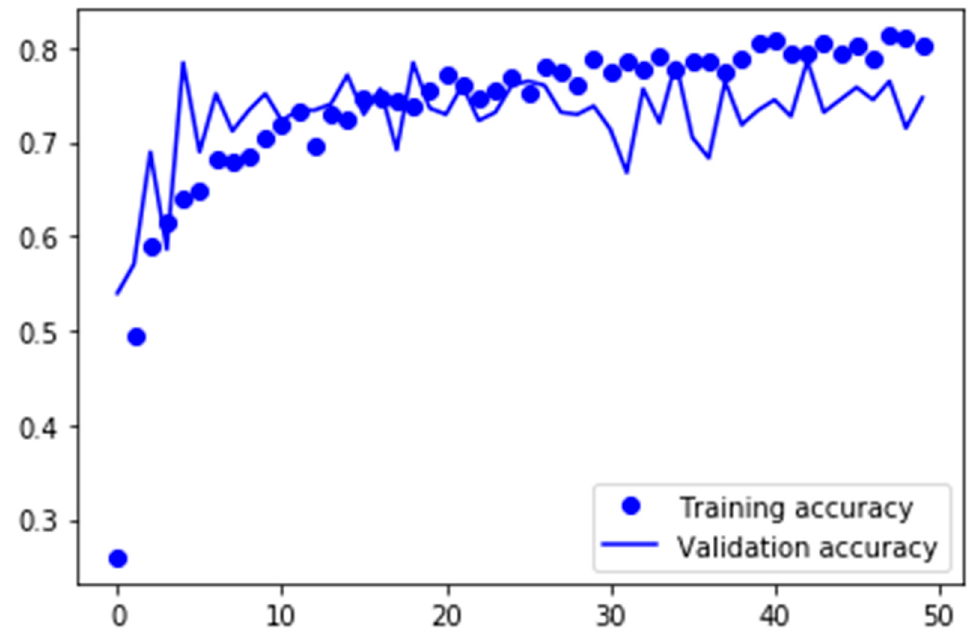
Figure 19. Training and validation accuracies for the transferred GoogLeNet, trained over 50 epochs.